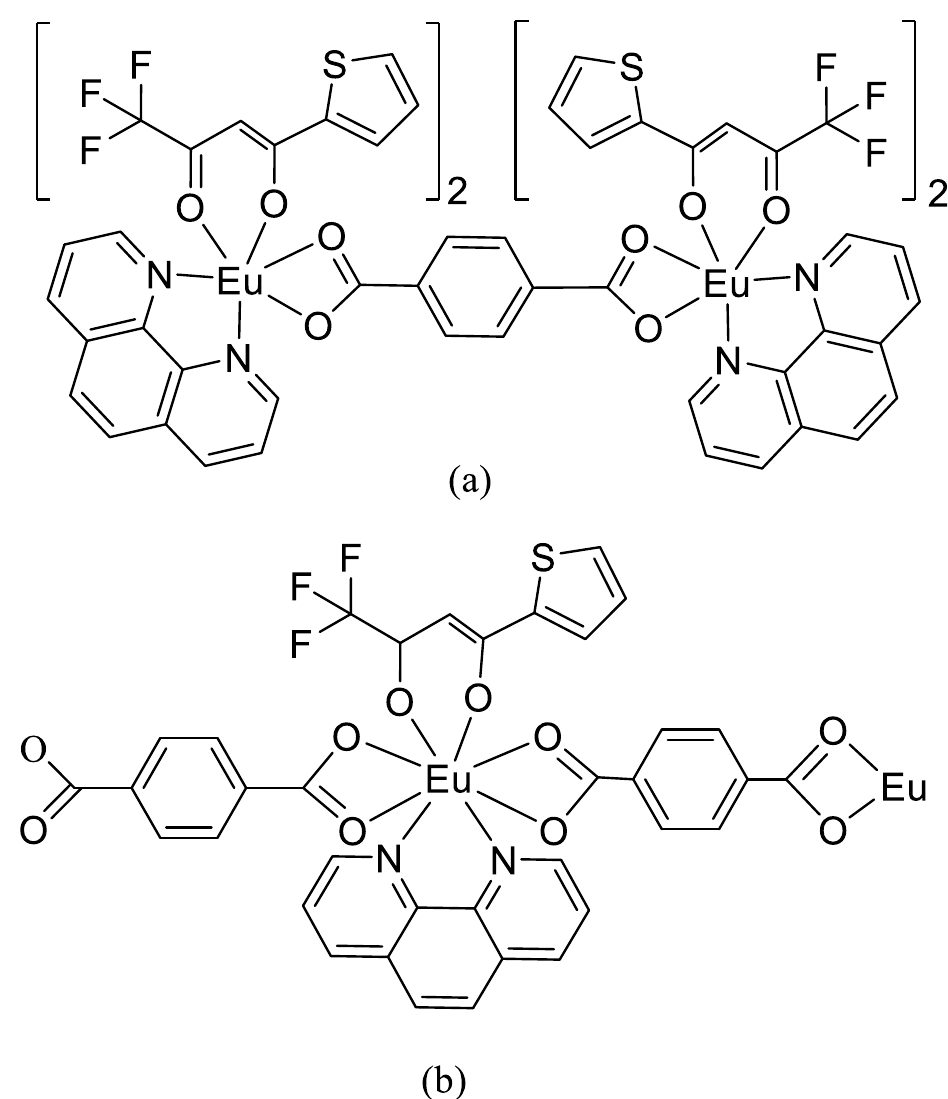
Figure 4. Chemical structures of complexes: ( a ) Eu 2 (TPA)(TTA) 4 Phen 2 ; ( b ) Eu(TPA)(TTA)Phen. Adapted with permission from ref. [30]. Copyright 2007 Springlink.